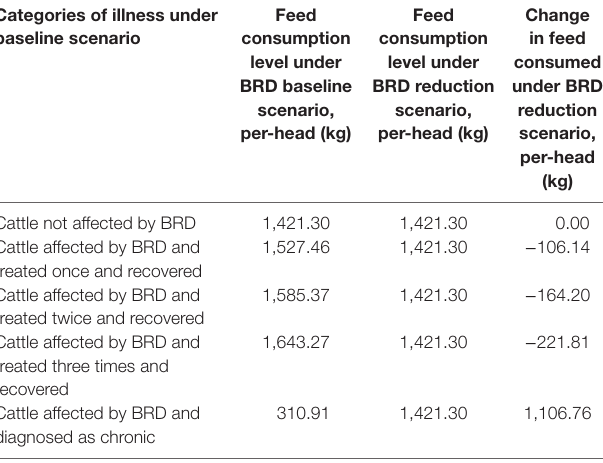
TaBle 1 | Feed consumption level and changes in feed consumption for cattle affected under the BRD baseline scenario but not affected under the BRD reduction scenario, per-head, by category of